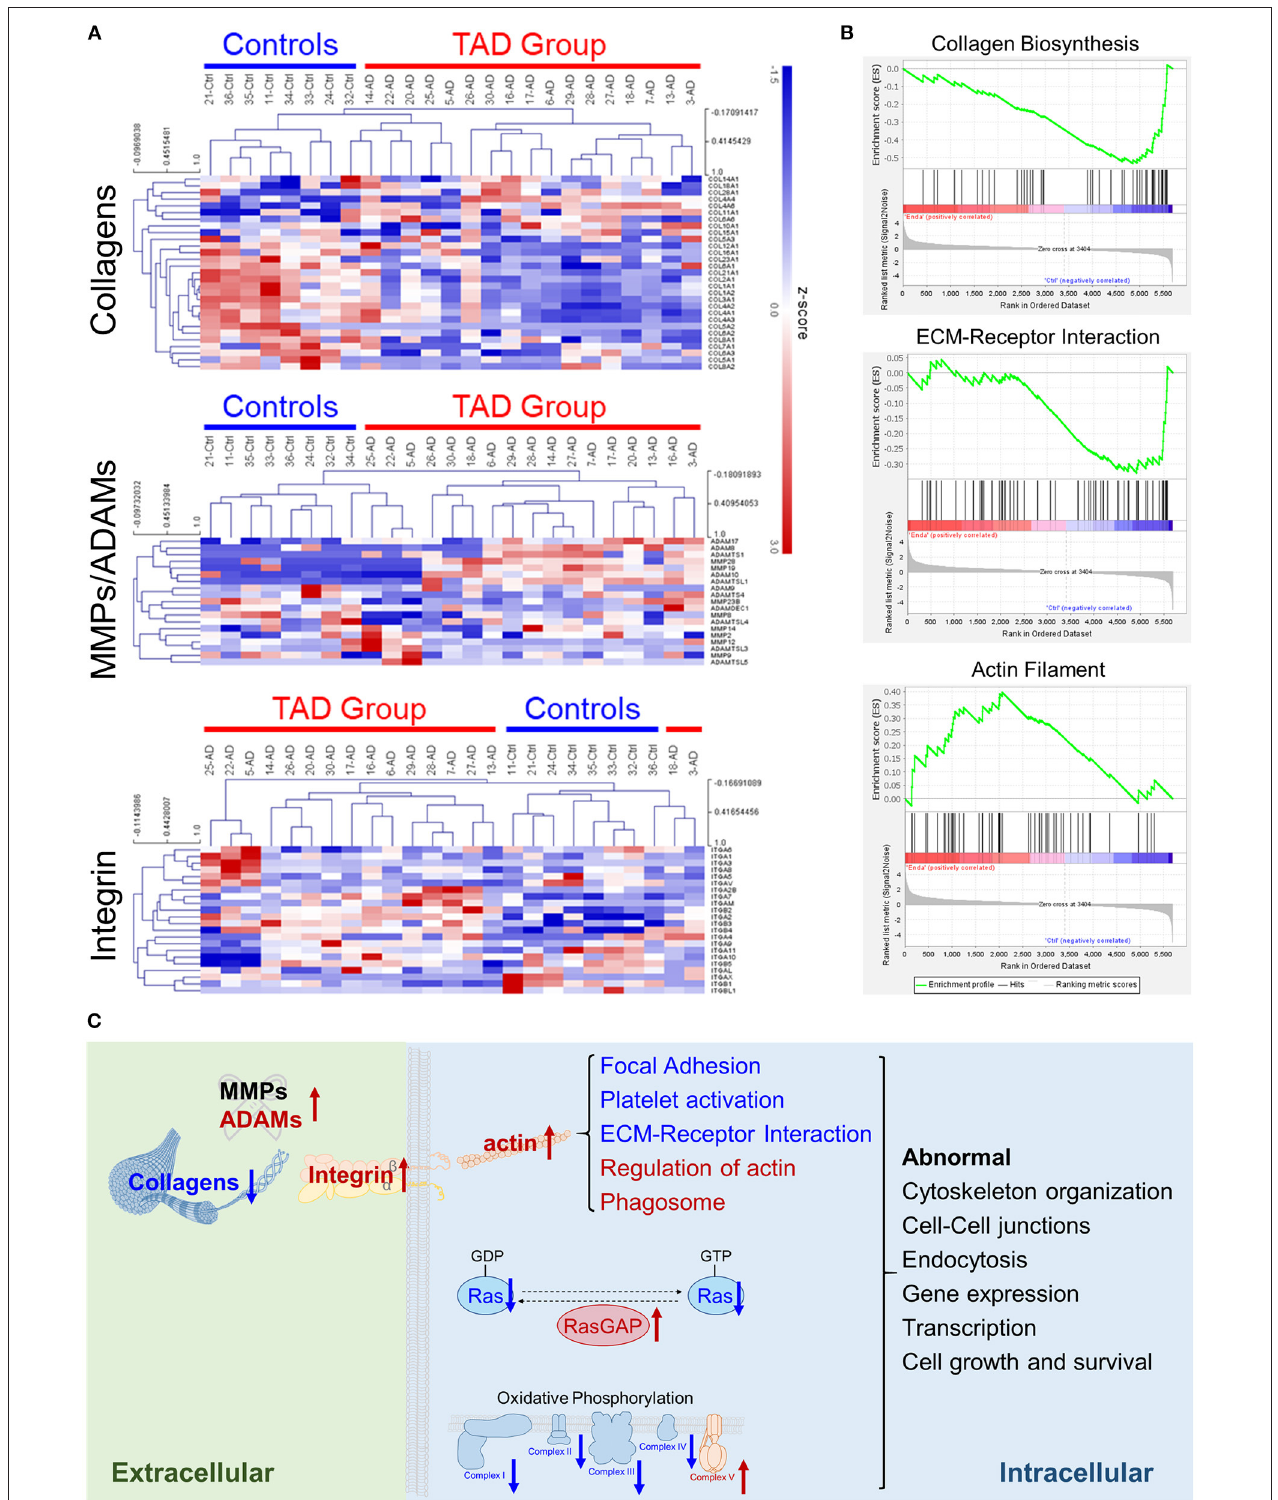
FIGURE 4 | Extracellular matrix (ECM) components are abnormal in TAD. (A) Cluster heatmaps of the protein families of collagens, MMPs and ADAMs, or integrins detected in tissue samples. Samples are clustered according to Pearson’s correlations. (B) Collagen biosynthesis, ECM-receptor interaction, and actin filament were enriched in the gene set enrichment analysis (GSEA). (C) Scheme of the abnormally expressed ECM components and pathways in TAD. The upregulated proteins are colored red, and the downregulated proteins are colored blue. The abnormal pathways of RAS and oxidative phosphorylation are shown in detail in Supplementary Figure 3